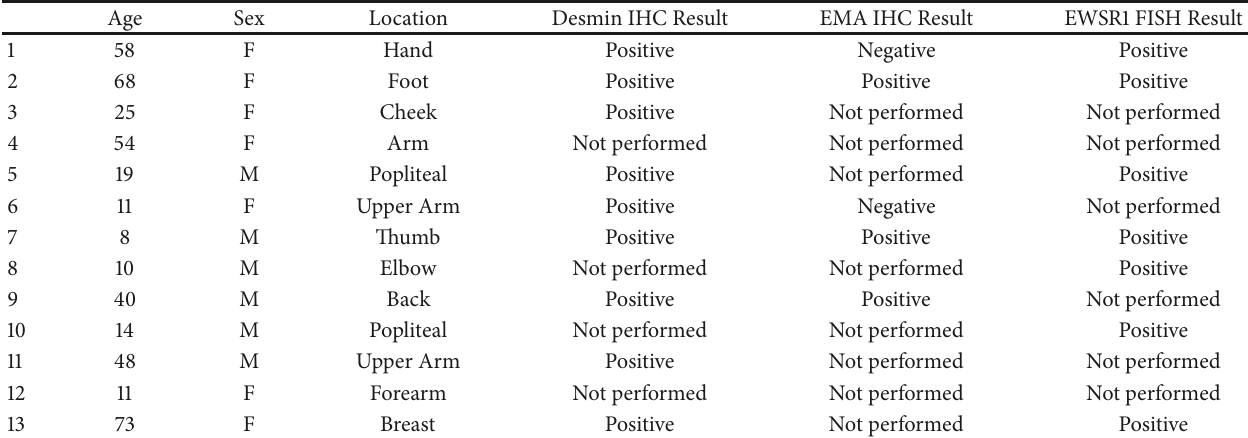
Table 1: Features of AFH cases from Cleveland Clinic (02/2012 through